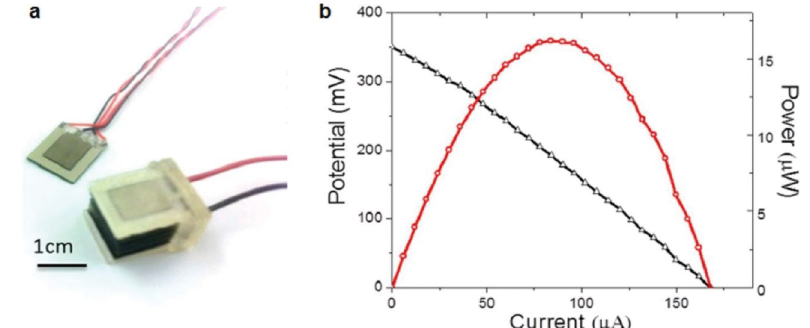
Fig. 4. (a) Picture of one double sided single layer glucose fuel cell along with a stack of 12 single layer glucose fuel cells (b) Performance of the 12 single layer glucose fuel cells stack connected in parallel